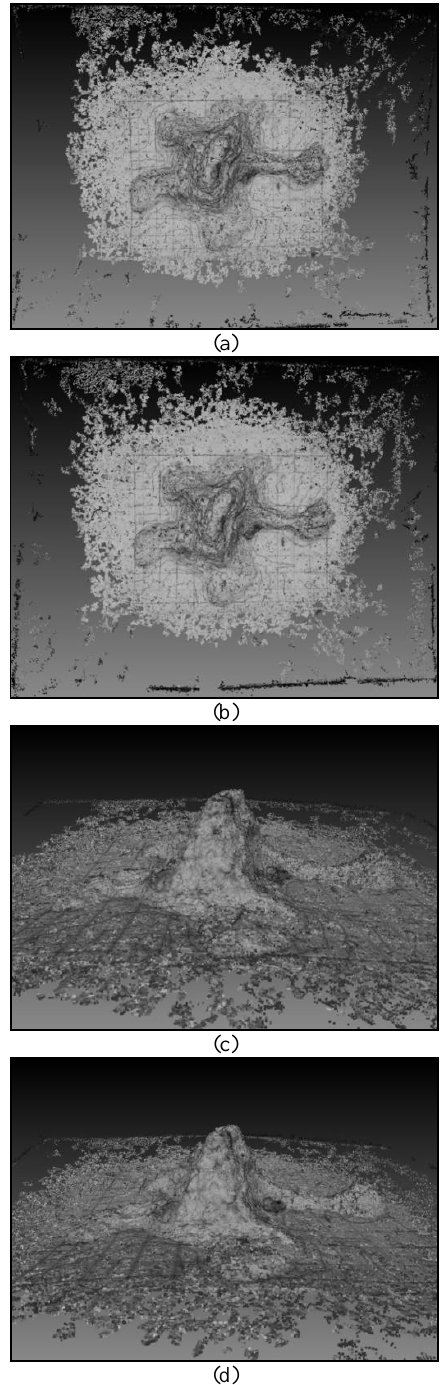
Figure 4: Sample views of the outputs using (a) SIFT by Lowe (2004), Top view; (b) SIFT by VlFeat, Top view; (c) SIFT by Lowe (2004), Front view; and (d) SIFT by VlFeat, Front view; The second test was performed to compare the outputs of using different values for the maximum photo width. SIFT by VlFeat was used for feature extraction. PMVS2 was used for point densification. A different object with more geometrical features Table 3. Output details of SFT by Lowe and SIFT by VlFeat was used as model for easier comparison. Figures 5(a), (b), and Detail (c) show the generated 3D point cloud using different maximum photo width. Upon visual inspection, it can be seen that varying the values for maximum photo width resulted to a significant difference in the densities of the output point